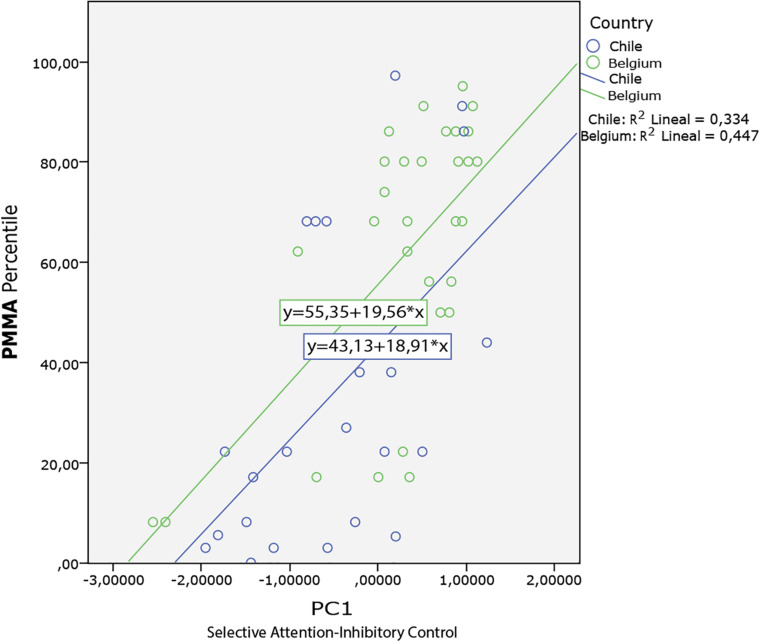
ANCOVA analysis. Geographical location as fixed factor Belgium (blue) and Chile (green) PC1as covariable and PMMA as dependent variable.